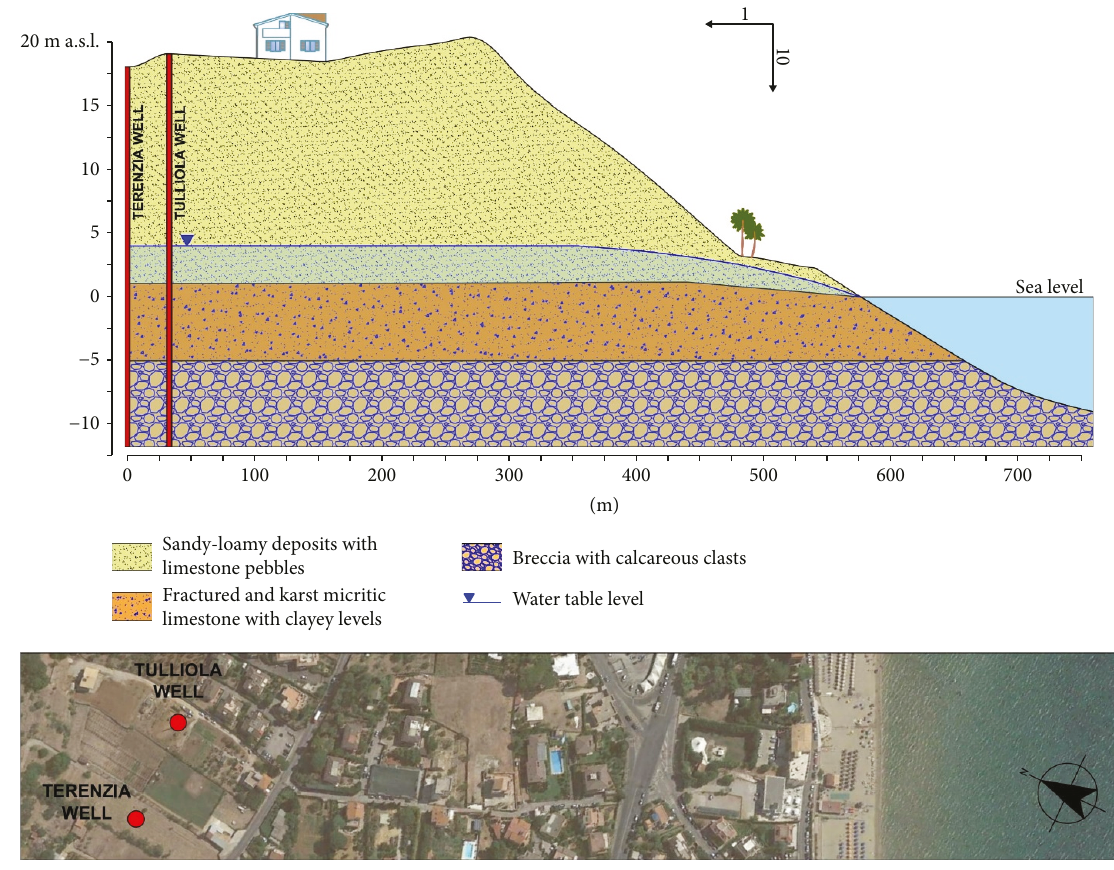
Figure 4: Geological cross section from the “ 25 Ponti ” well fi eld to the